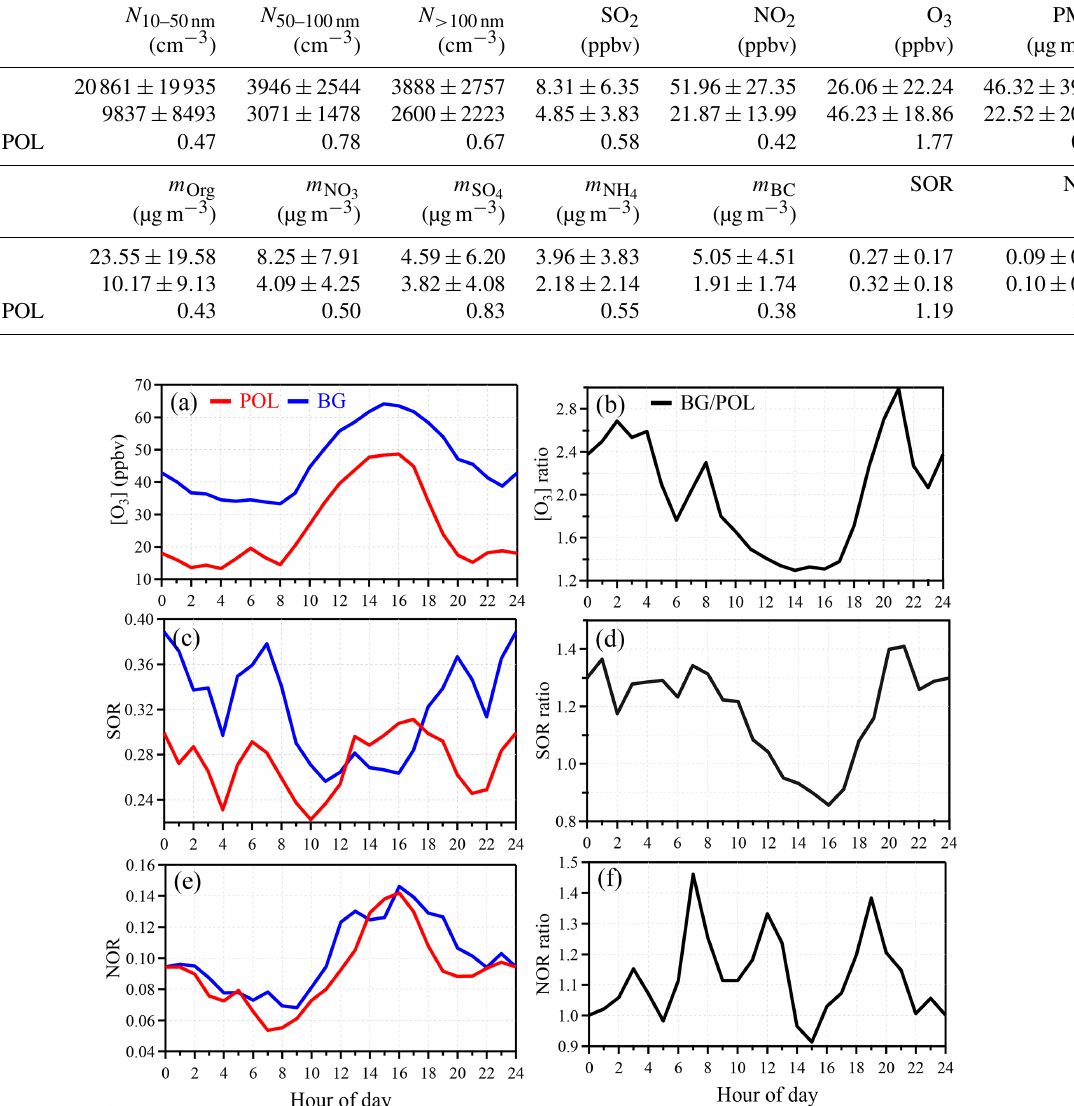
Figure 6. Diurnal variations in (a, b) O 3 volume mixing ratio and its ratio, (c, d) sulfur oxidation ratio (SOR) and its ratio, and (e, f) nitrogen oxidation ratio (NOR) and its ratio during the BG and POL periods. The ratio of a quantity is that quantity during the BG period divided by that quantity during the POL